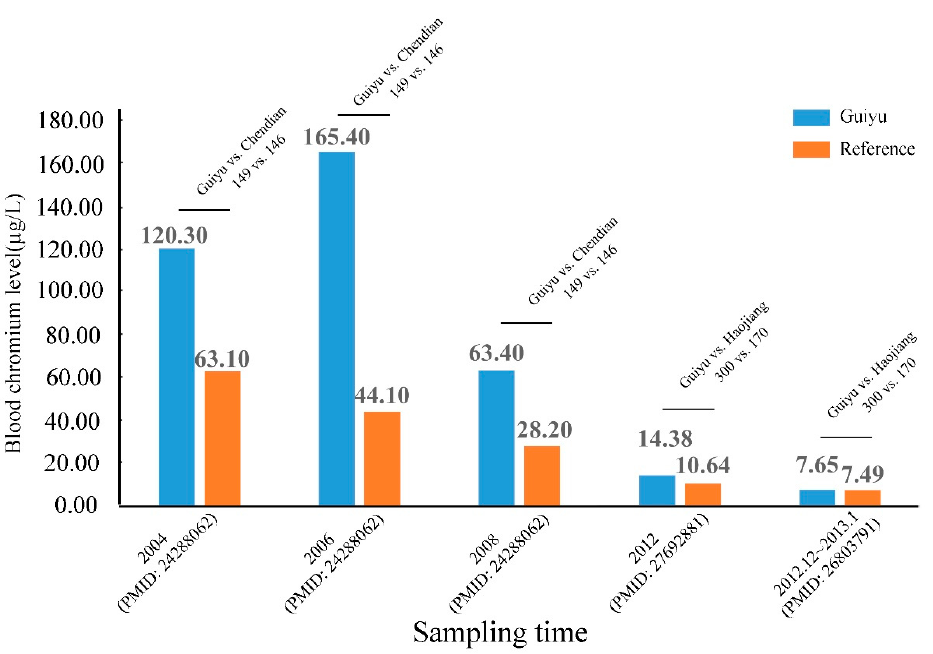
Figure 3. Blood Cr levels of children from Guiyu and reference sites from 2004 to 2012.